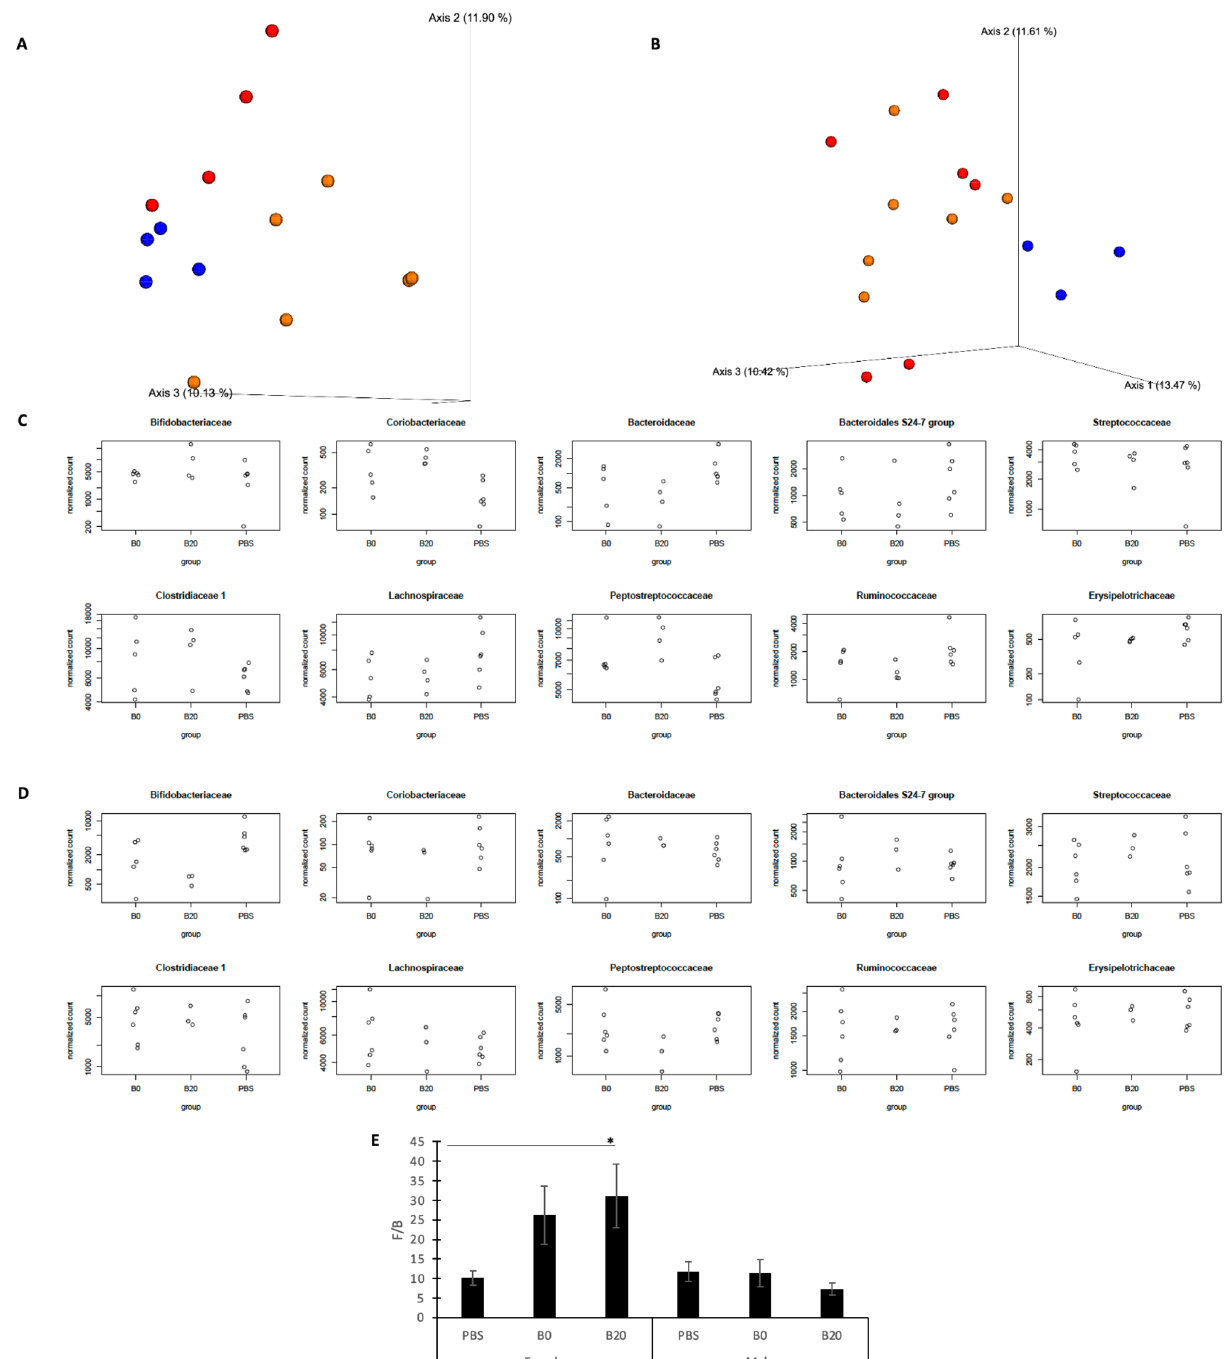
Figure 1. The relative abundance of bacterial levels in mice cecum samples. PCoA plots based on OTU of mice cecum samples. The results were generated based on the Jaccard distance matrix. Females ( A ) and males ( B ). The colors represent different group identities, of which red stands for B0, blue stands for B20 and orange stands for PBS group. Expression (DESeq2 normalized counts) of 10 bacterial families for PBS, B0, and B20 groups are shown for both females ( C ) and males ( D ). ( E ) The comparison of calculated ratio of Firmicutes to Bacteroidetes for both female and male groups. *Indicates statistical significance with p <